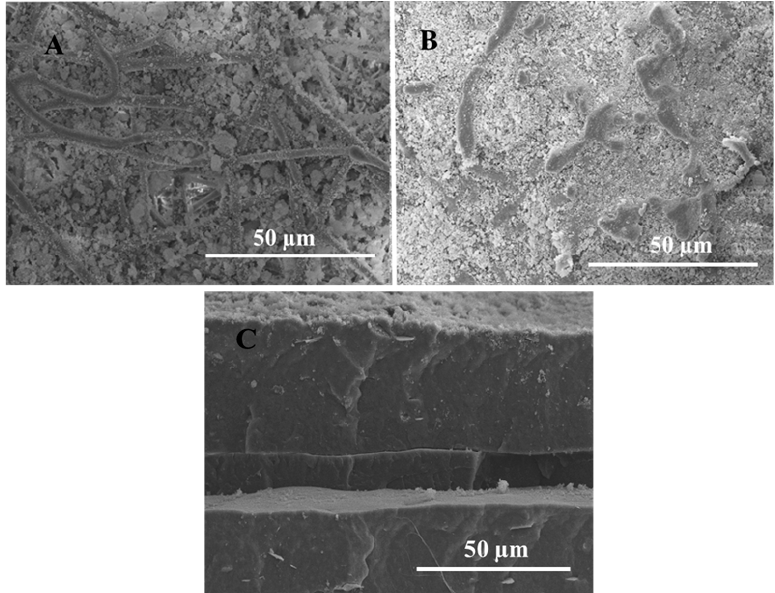
Figure 4. SEM images of: ( A ) the top view of SiO 2 deposited on top of PHBV; ( B ) top view of SiO 2 deposited on top of PHBV after annealing at 130 °C; and ( C ) cross-section of the multilayer film after ◦ C; and ( C ) cross-section of the multilayer film after annealing at 130 °C. deposited on top of PHBV after annealing at 130 annealing at 130 ◦